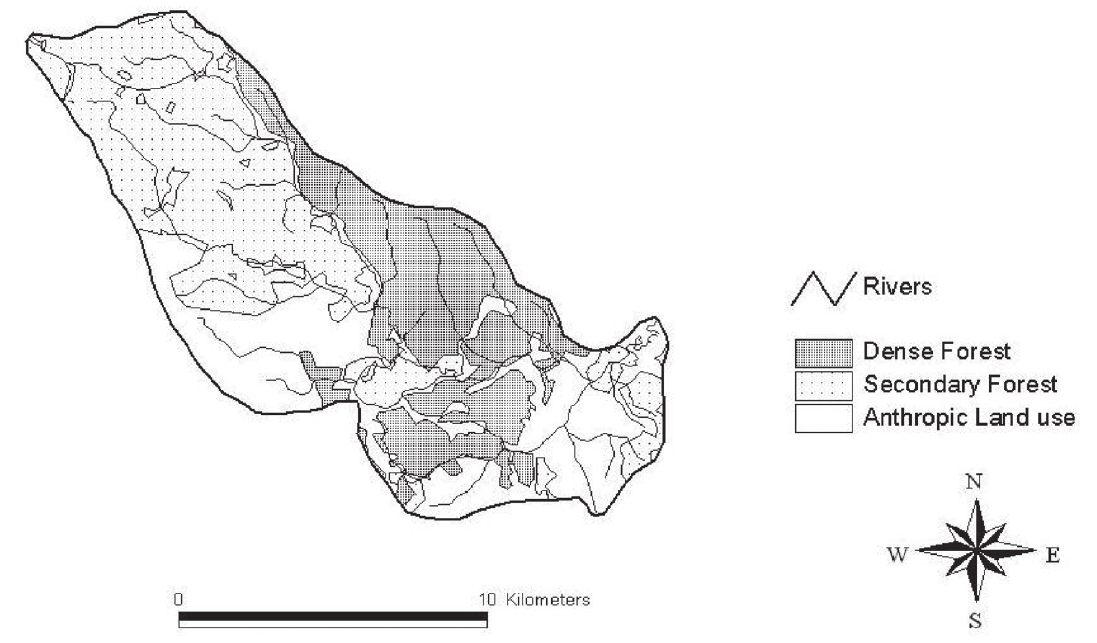
Figure 2 - Land cover at Rio da Serra Basin. Obtained from LandSat images mapped with ArcView software. Black dots resemble sampling stations as Figure